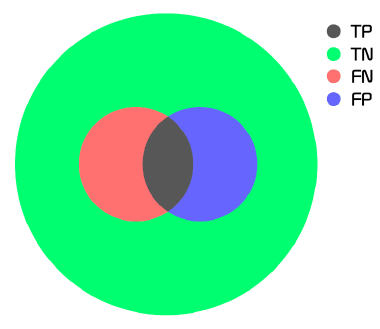
Figure 13. Illustration of the confusion matrix.